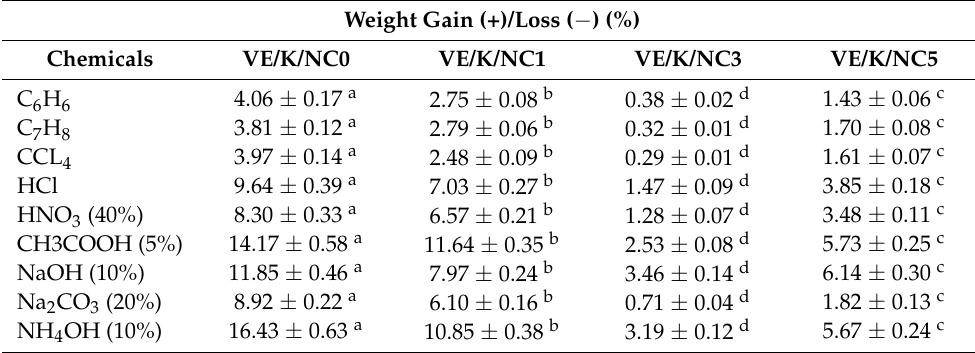
Table 3. Chemical resistance properties of different loading of activated bionanocarbon reinforced